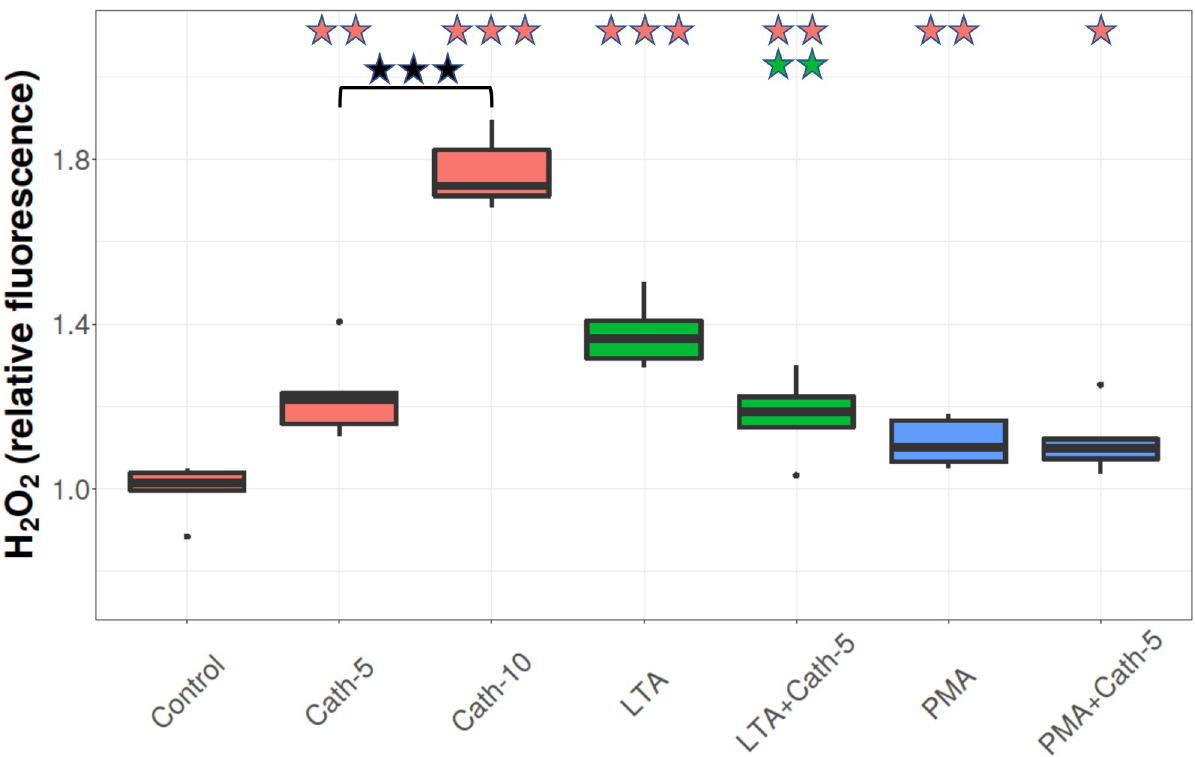
Fig 7. H 2 O 2 concentration. Boxplots showing the hydrogen peroxide (H 2 O 2 ) concentration for hepatocyte—non-parenchymal cell co-cultures treated with chicken cathelicidin-2 (Cath), lipoteichoic acid (LTA), or phorbol myristate acetate (PMA) only, or the combination of Cath and LTA or PMA (n = 6/group). Results are displayed as relative flurescence, where 1 is the mean value of control cultures. Cath-5 = 5 nmol/mL Cath, Cath- 10 = 10 nmol/mL Cath, LTA = 50 μ g/mL Staphylococcus aureus LTA, PMA = 1000 ng/mL PMA. The Control refers to absolute control cells that received none of the treatments. Red asterisks over the boxes refer to significant differences compared to control cells, green asterisks to the group treated only with LTA, blue asterisks to the group treated only with PMA, and black asterisks between the two concentrations of Cath. �� p < 0.01, ��� p <